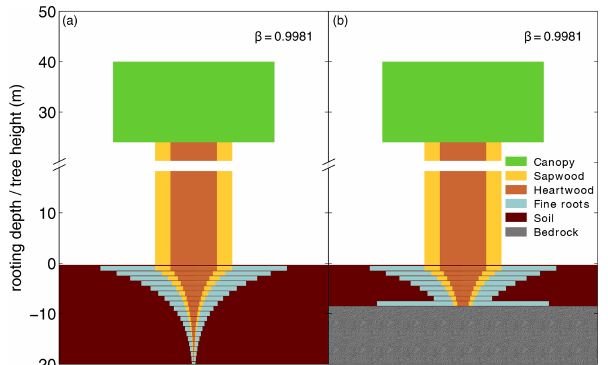
Figure 1. Visualization of below-ground carbon allocation to dif- ferent carbon pools of a tree PFT in LPJmL4.0-VR with a height of 40m and a D 95_max of 14m (sub-PFT no. 8 in Table A2) grow- ing in a grid cell with a soil depth of 20m (a) and a soil depth of 7m (b) . As with stem sapwood, root sapwood also needs to sat- isfy the pipe model. In the first soil layer the root sapwood cross- sectional area is equal to the stem sapwood cross-sectional area, as all water taken up by fine roots needs to pass this layer. In each fol- lowing soil layer, the root sapwood cross-sectional area is reduced by the sum of the relative amount of fine roots of all soil layers above, thus adjusting the amount of sapwood needed to satisfy the pipe model. Please also see Supplementary Video 1 for a visual- ization of root growth and development of below-ground carbon pools over time available at http://www.pik-potsdam.de/~borissa/